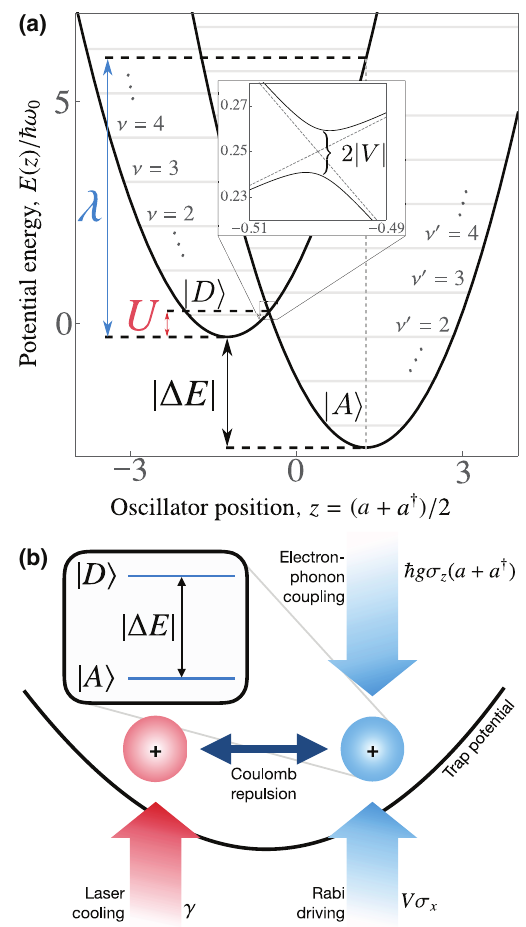
FIG. 1. Electron-transfer theory. (a) The vibrational-energy landscape deduced from the Hamiltonian (1), composed of the adiabatic Born-Oppenheimer (BO) surfaces for the electronic states D and A , as a function of the reaction coordinate defined by the dimensionless harmonic oscillator position variable z . The diabatic BO surfaces, E D ( z ) (left parabola) and E A ( z ) (right parabola), respectively, are identified by dashed gray lines in the inset. For the weak coherent coupling assumed here, adia- batic and diabatic surfaces are indiscernible on the scale of the main plot. The D - A energy gap (cid:2) E = E A − E D [which is nega- tive given the electronic level structure depicted in (b) below], the reorganization energy λ , the activation energy U , and the coherent coupling V (inset) are indicated. The horizontal lines indicate vibrational levels ν ( ν (cid:4) ) of the D ( A ) BO surface upon quantization. The employed parameters are | (cid:2) E | = 2.5 (cid:2) ω 0 , V = 0.01 (cid:2) ω 0 , and g = 2.5 ω 0 , where ω 0 denotes the (effective) trap frequency. (b) A “system” ion (blue) simulates the donor- acceptor system with the two electronic states | D (cid:2) and | A (cid:2) (akin to a spin 1 / 2). Laser-driven Rabi oscillations (blue upward arrow) induce coherent coupling of strength V between the donor and acceptor states. A second laser (blue downward arrow) induces spin-phonon coupling between the electronic degree of freedom of the “system” ion and a collective motional mode of both ions. This mode is sympathetically cooled by laser inter- action (red arrow) through a “cooling” ion (red) of a different